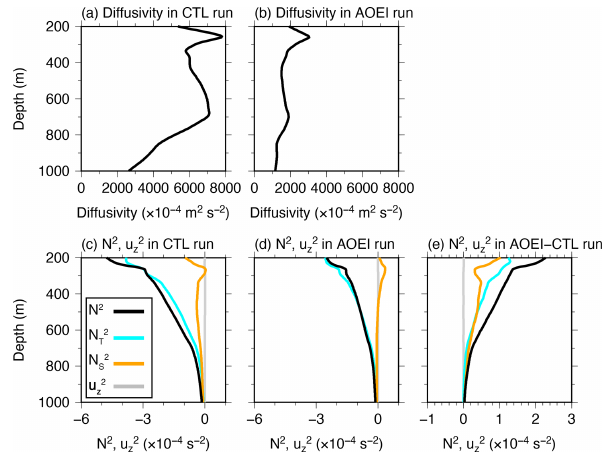
Figure 9. Total vertical diffusivity tendency during the positive ver- tical diffusivity tendency period averaged over the KE region (30– 40 ◦ N, 140–160 ◦ E) in the (a) CTL and (b) AOEI runs. Panels (c) and (d) are the same as panel (a) but for the squared buoyancy fre- quency (black) and shear (gray) tendency. Panel (e) is the same as panels (c) and (d) but for the AOEI minus CTL run. In pan- els (c) – (e) , cyan (orange) lines indicate contributions from ∂N 2 /∂t ). ( ∂N 2 S